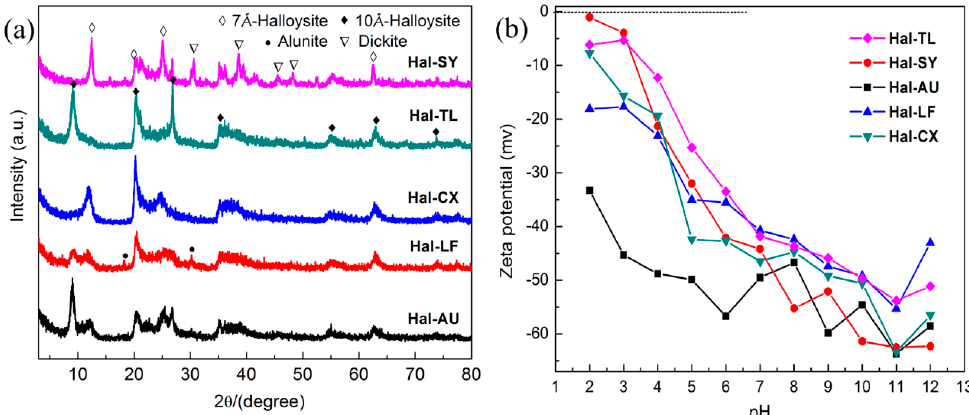
Figure 1. ( a ) XRD patterns of powdered samples of halloysite minerals; ( b ) Zeta potential measurements for different halloysite samples.